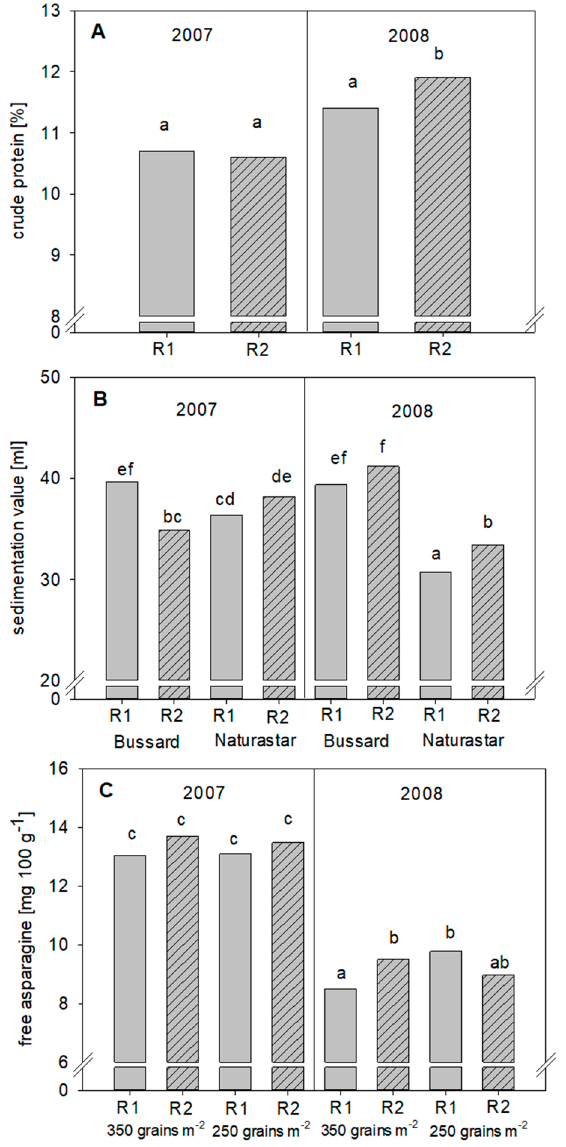
Figure 2. Level of crude protein ( A ) sedimentation value ( B ) and free Asn ( C ) in dependence of their highest significant interaction. Row distance R1: 12.5 cm (solid columns), R2: 30 cm (hatched columns). Seed density: 350 and 250 grains m − 2 . If no cultivar or only one treatment appears, columns refer to averages. This was the consequence of there being no significant impacts of single treatments. Columns with different letters only within each single trait indicate significant differences ( α = 0.05, t -Test).